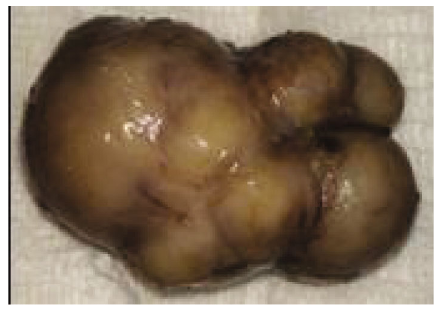
Figure 3: Macroscopic aspect of the leiomyoma.